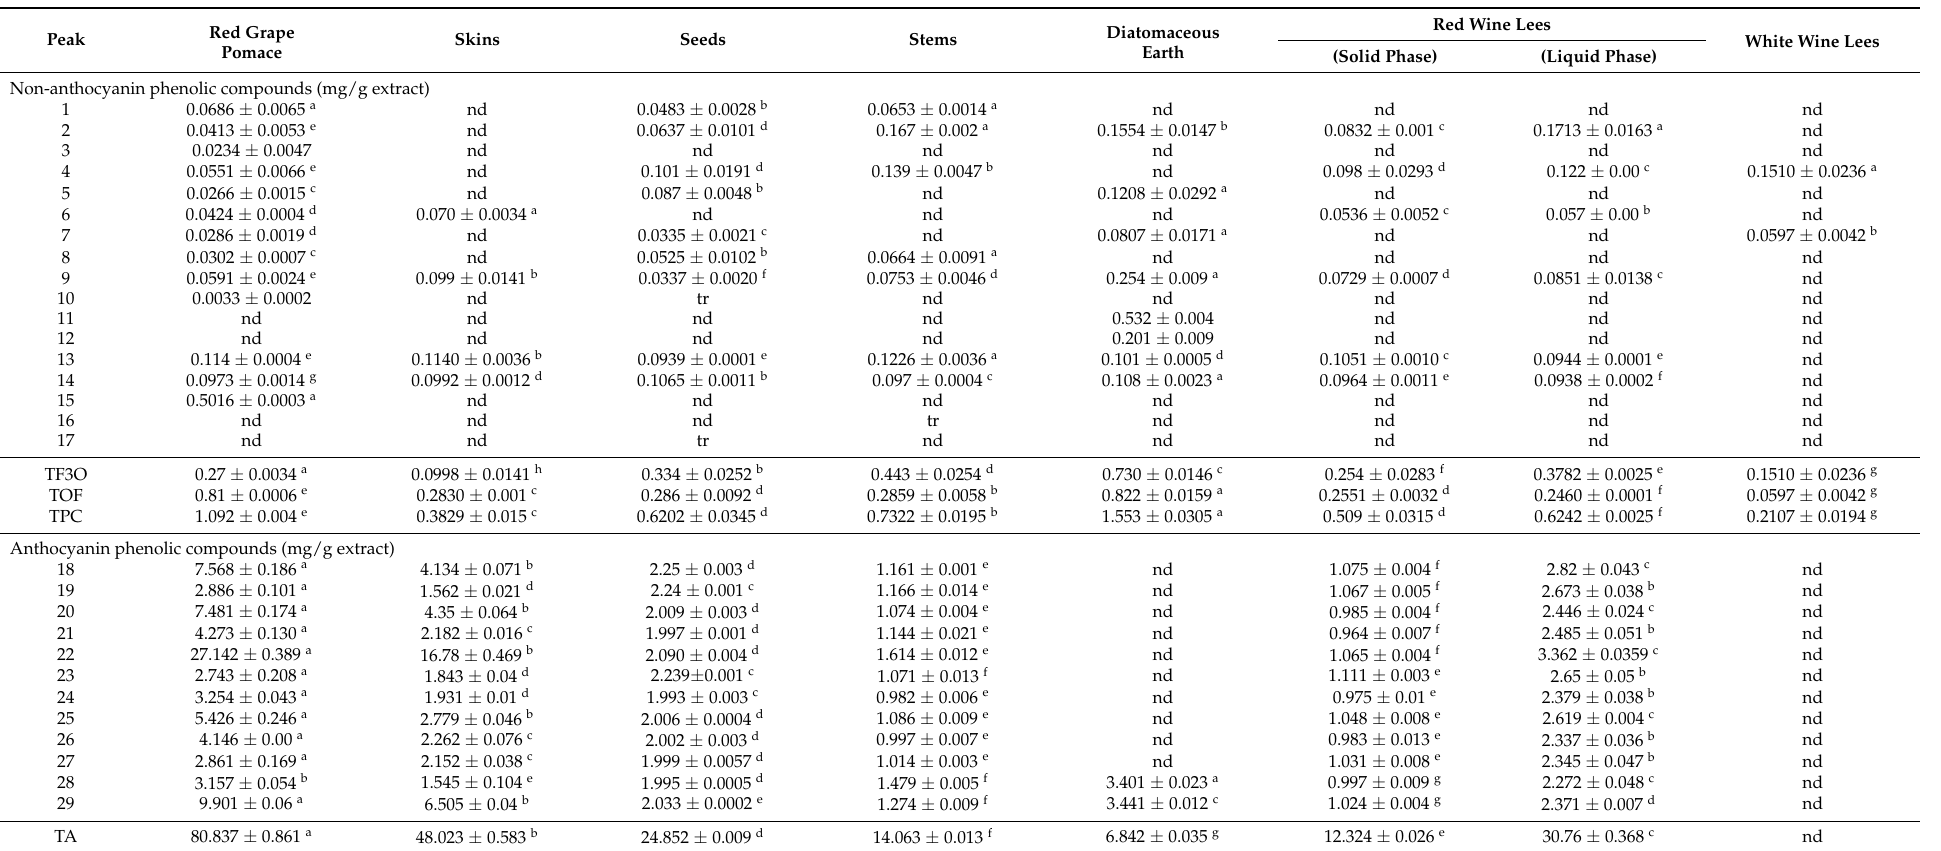
Table 2. Quantification of the non-anthocyanin and anthocyanin phenolic compounds found in the hydroethanolic extracts of winemaking residues from the year 2021 (mean ± standard